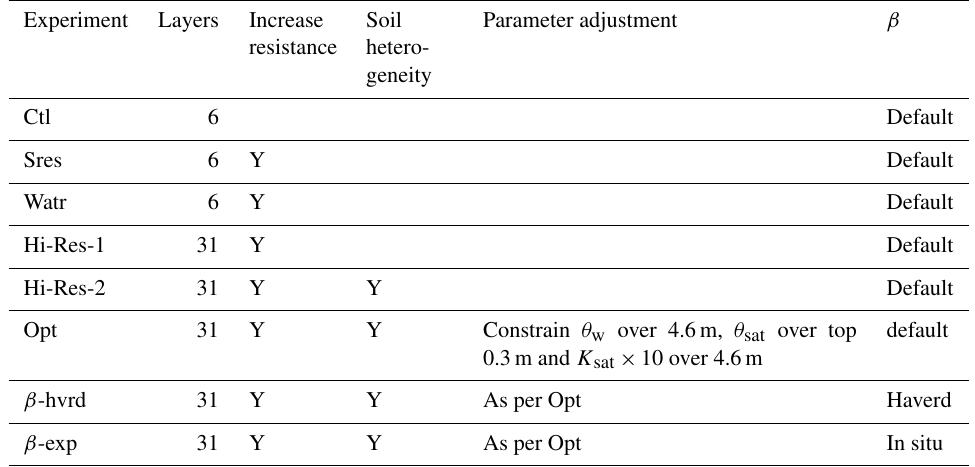
Table 1. The experiments conducted. Layers refers to the number of soil layers. Increase resistance refers to increasing surface resistance to soil evaporation. Soil heterogeneity indicates whether soil properties and hydraulic parameters change with depth. The adjustment of θ w , θ sat and K sat and the method used to calculate β are the final two